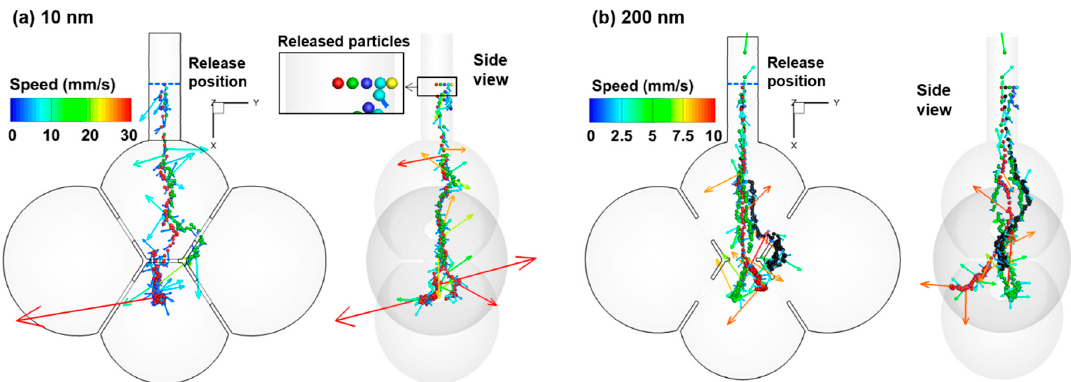
Figure 4. Brownian motion of nanoparticles with a diameter of ( a ) 10 nm and ( b ) 200 nm with their instantaneous velocities superimposed. Five particles were released from the middle of the duct. The pore size of the alveolar model is 40 µm.